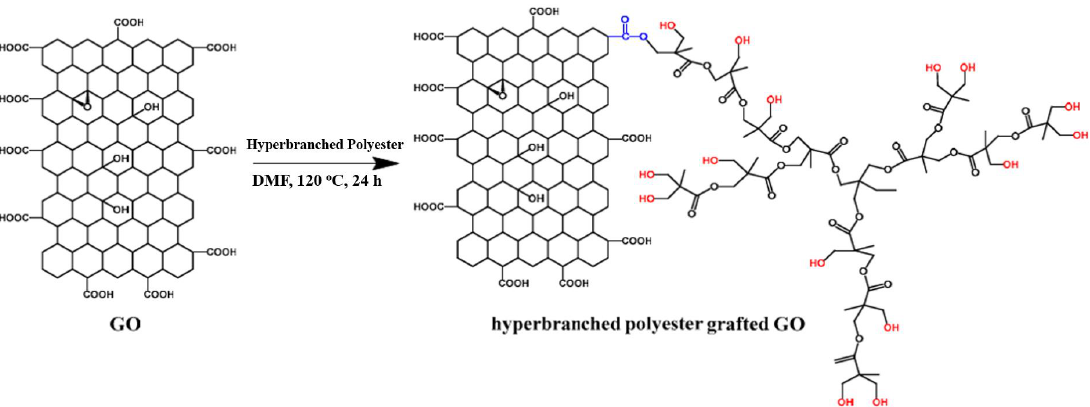
Scheme 1. Illustration of the reaction between GO and hyper-branched polyester.